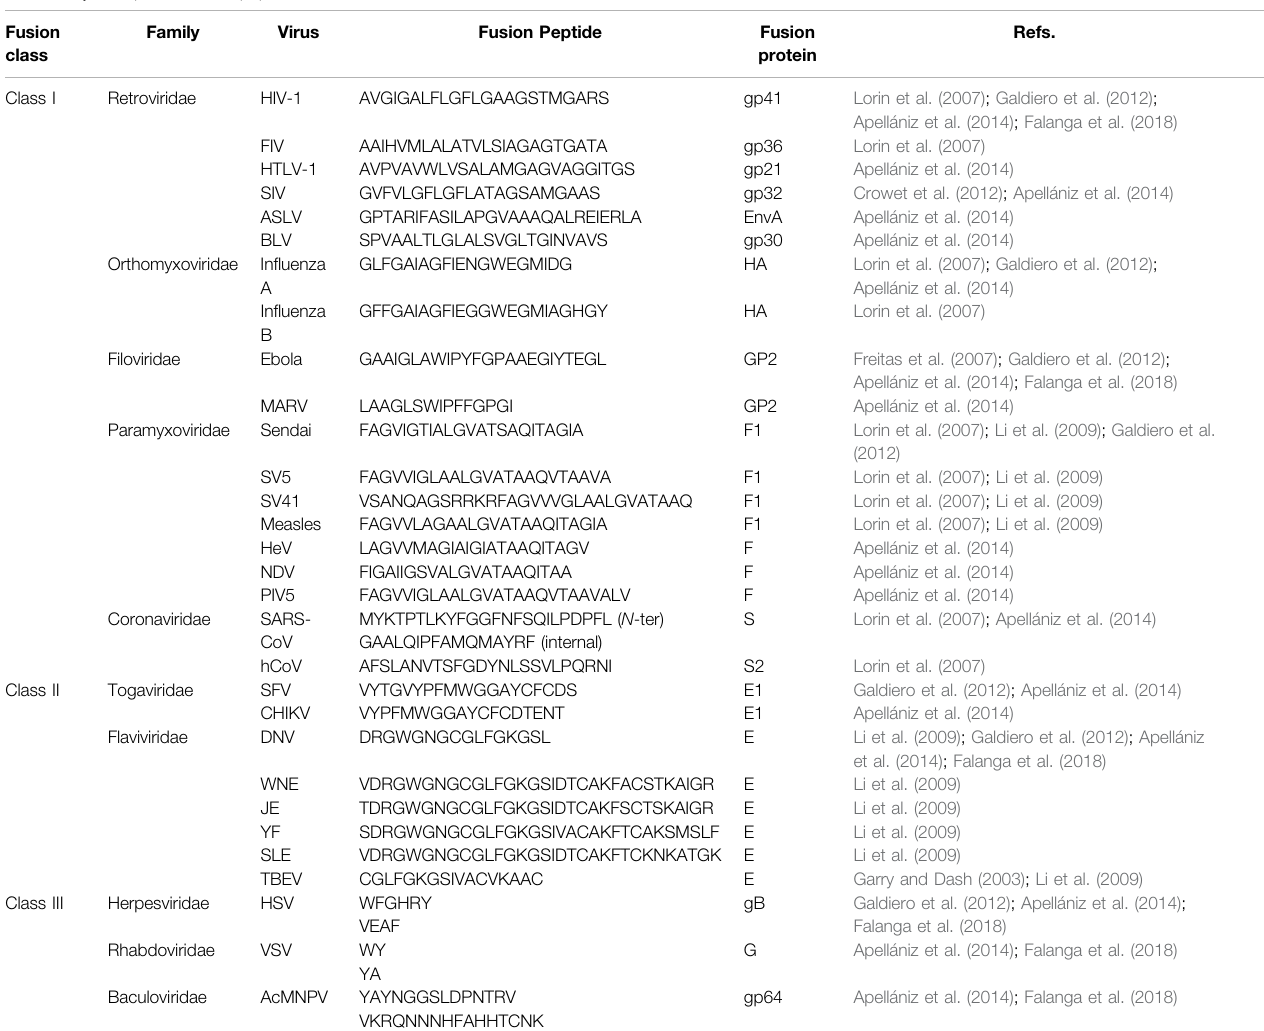
TABLE 1 | Examples of fusion peptides from different virus